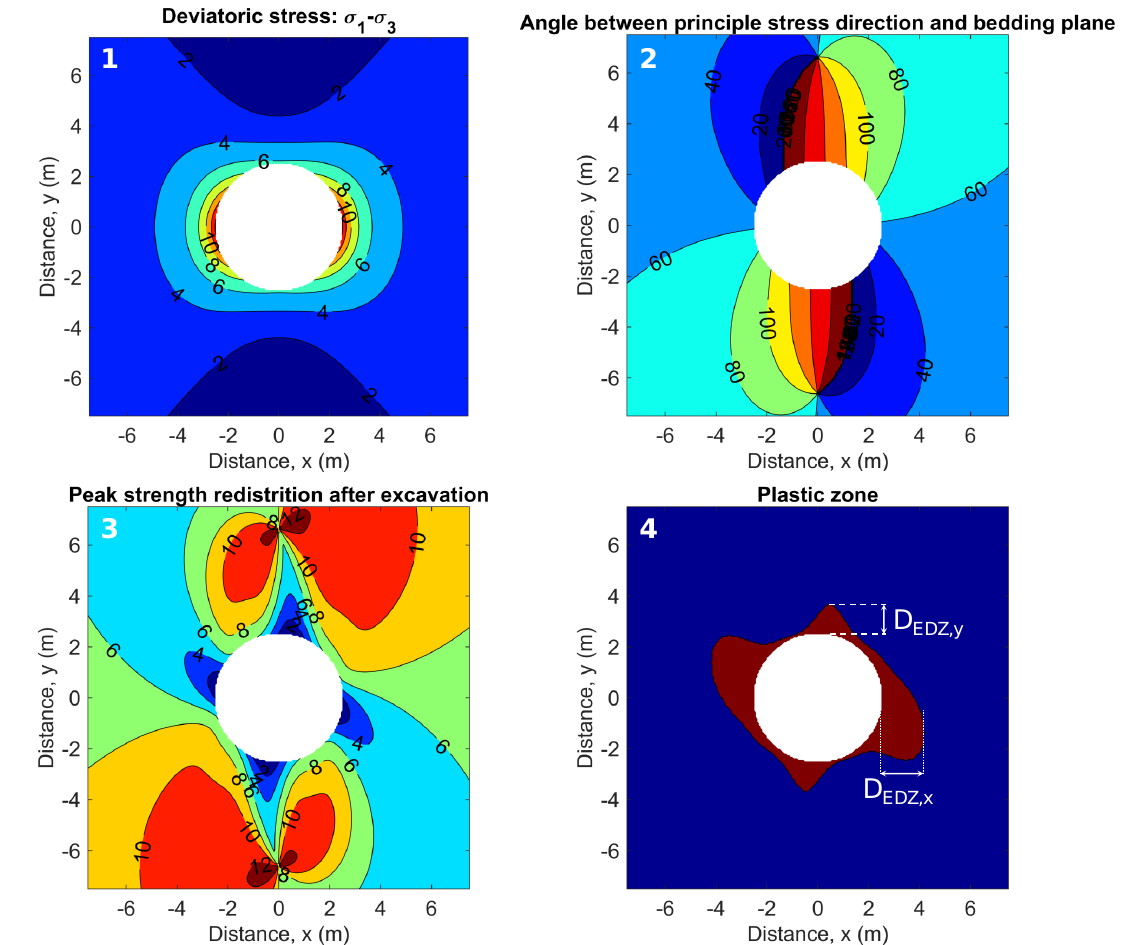
Figure 11. A hypothetical EDZ extent determination process for a circular tunnel (diameter 2.5 m): ( 1 ) the initial vertical stress is larger than the horizontal; ( 2 ) the material is transversely isotropic elastic; ( 3 ) the McLamore and Gray elasticity model is adopted; ( 4 ) the maximum EDZ extent is characterized in the horizontal and vertical directions by D EDZ,x and D EDZ,y ,